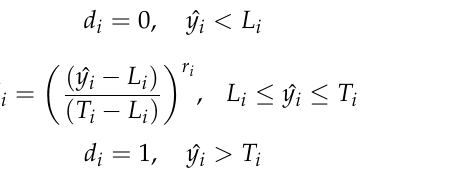
Figure 6. Surface plots of tensile shear load. ( a ) Penetration depth and plunge speed; ( b ) penetration depth and dwell time; ( c ) dwell time and plunge speed.